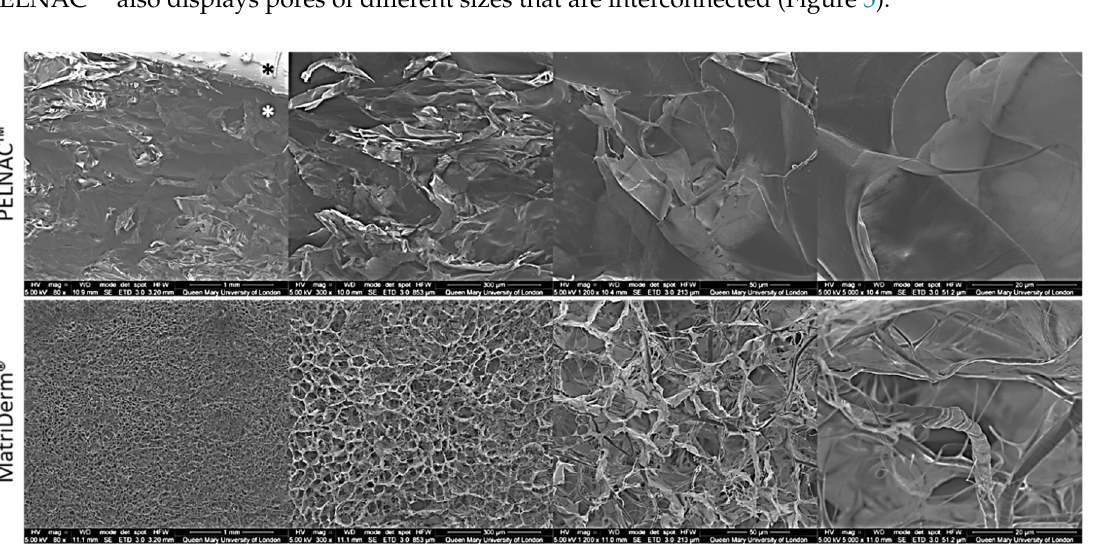
Figure 5. SEM images of commercially available skin scaffolds MatriDerm ® and PELNAC™ used in this study. Black * indicates the silicone membrane while white * indicates the sponge of PELNAC™.